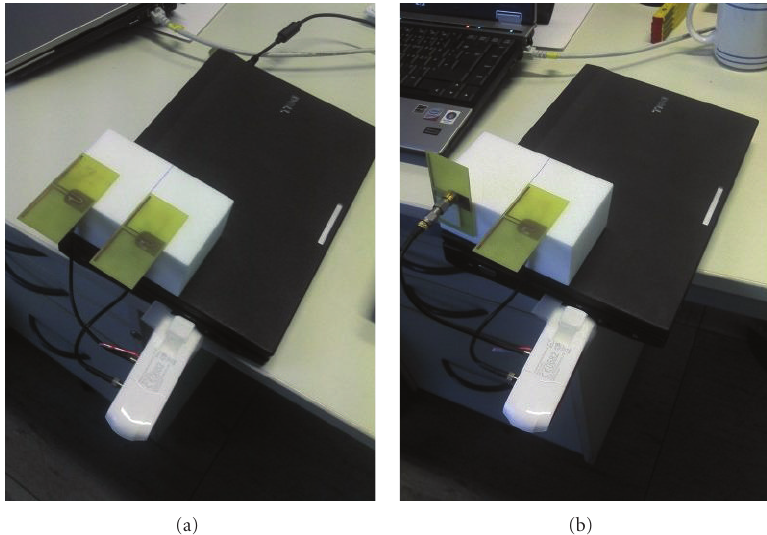
Figure 6: Band 7 dongle in a test setup with 2 external antennas, (a) collinear dipole arrangement and (b) cross-polarized dipoles.